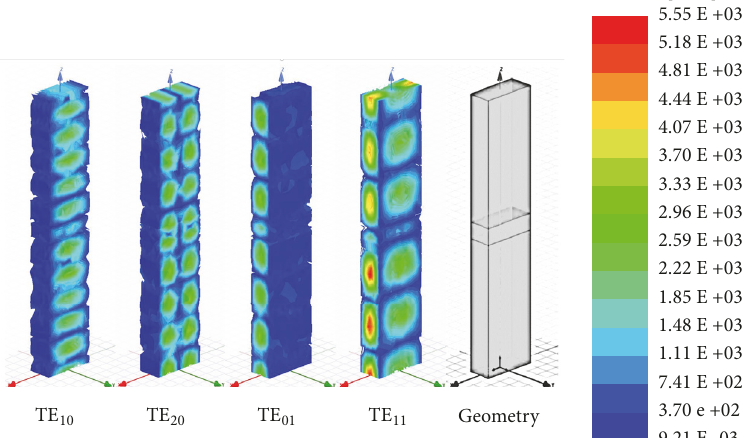
Figure 6: Simulated configurations for the magnitude of the electric field for 4 TE modes at 18 GHz with a polyurethane sample inserted inside the rectangular waveguide.